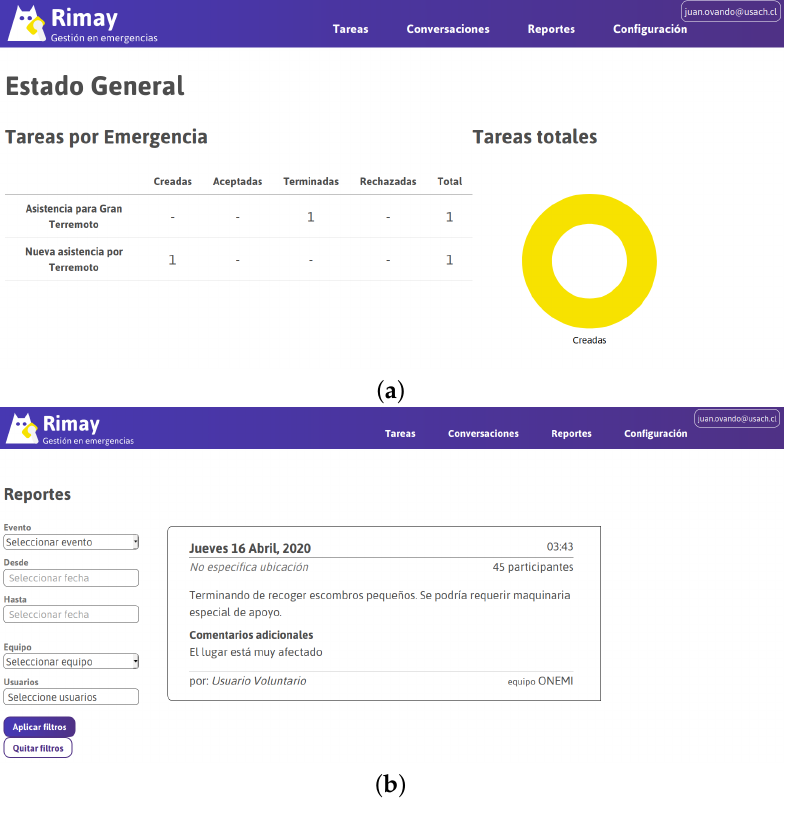
Figure 6. Screenshots of Rimay’s Front-end application: ( a ) statistics report on events and ( b )